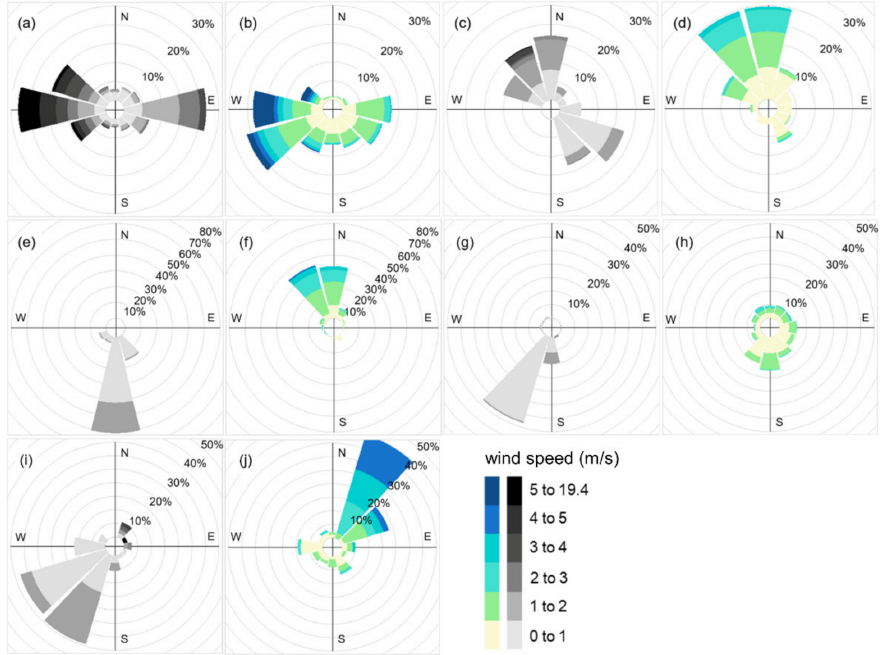
Figure 9. Overview of wind directions and wind speeds for the week from 8 April to 15 April 2020 divided into night from 9 pm to 7 am (grey) and day from 7 am to 9 pm (coloured) for ( a , b ) UFS, ( c , d ) Kreuzeck, ( e , f ) Hausberg, ( g , h ) Eibsee and ( i,j )